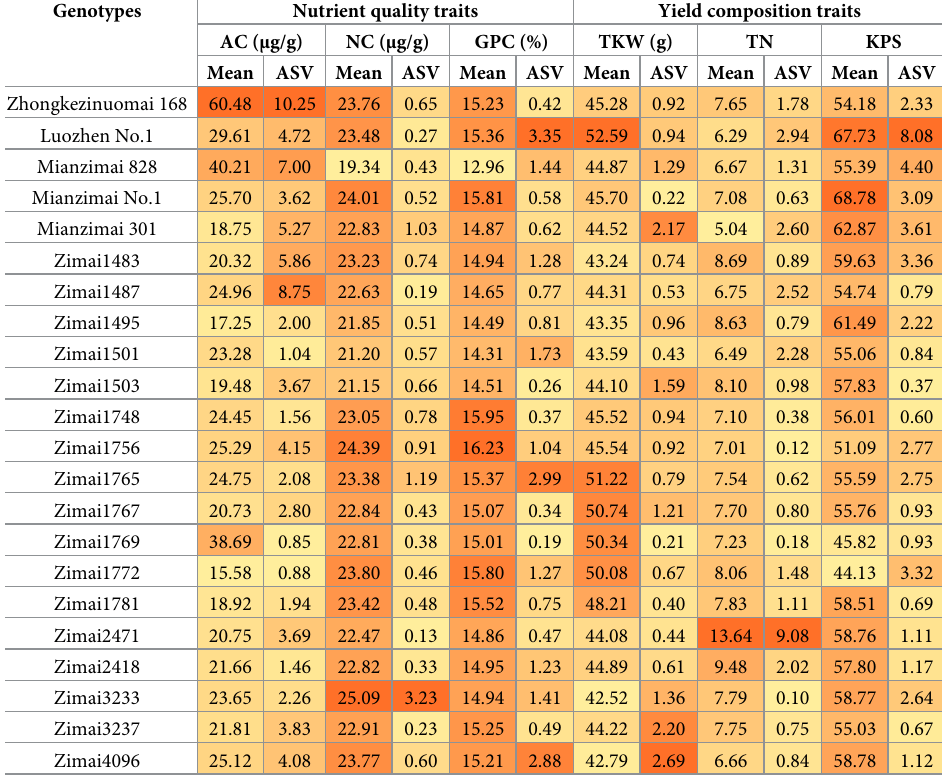
The highlighted color is deepening with the corresponding average values or ASVs increasing AC anthocyanin content, NC nitrogen concentration, GPC protein content, TKW thousand-kernel weight, KPS kernels per spike, TN tiller